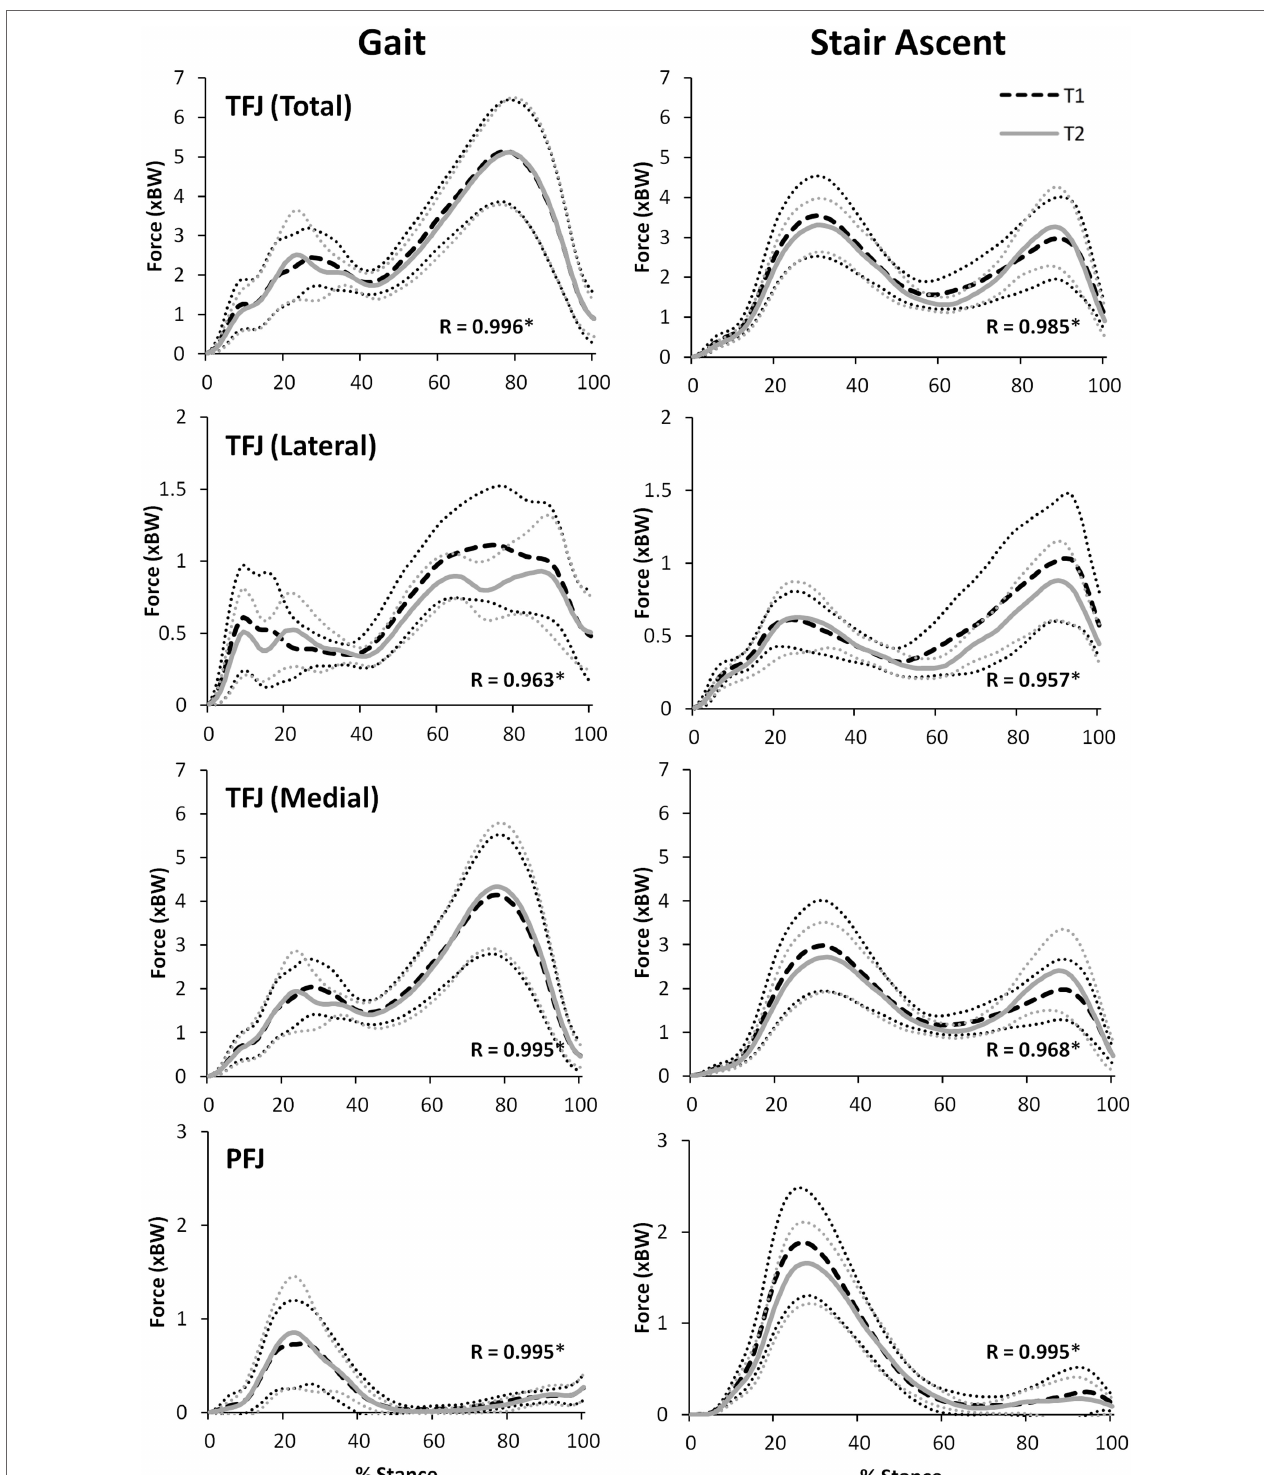
FIGURE 8 | A comparison of group mean knee joint contact forces (TFJ, tibiofemoral joint contact force; PFJ, patellofemoral joint contact force) from two data collection sessions separated by 24h. 95% confidence intervals for session one and two are represented by the thin, dotted black and grey lines, respectively. Correlation coefficients ( R ) are also included where * indicates a significant correlation ( p <0.05).